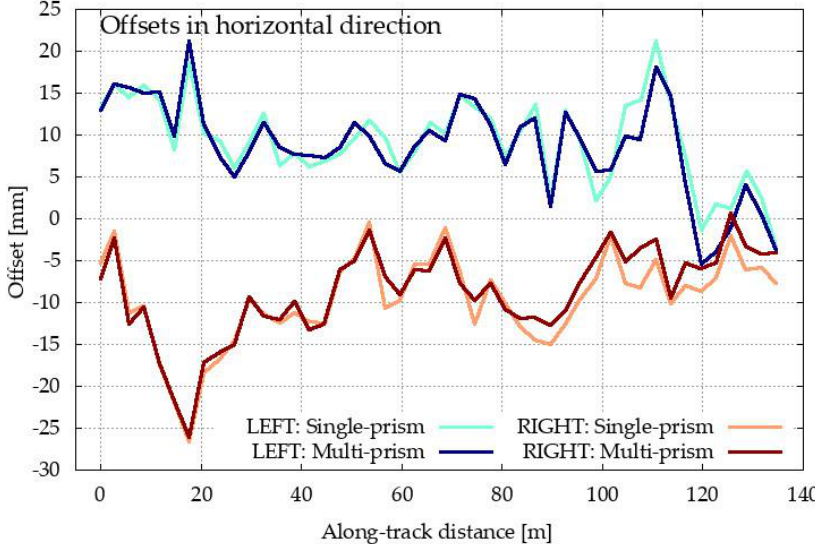
Figure 13. Offsets of the determined characteristic point 𝐂 from its designed value in the horizontal direction for both methods (single- and multi-prism) and both inrun tubes (left and right).